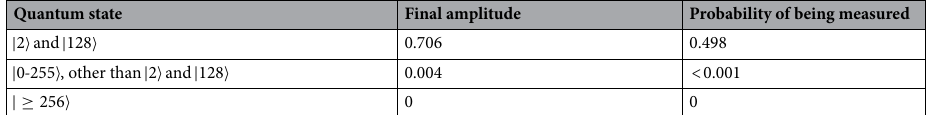
Table 1. The output vector states in the simulation with 8 data qubits. Quantum states | 2 � and | 128 � are the states of the targets. The sum of the measured probabilities of these two states is close to 1, showing that the proposed quantum circuit can obtain the correct